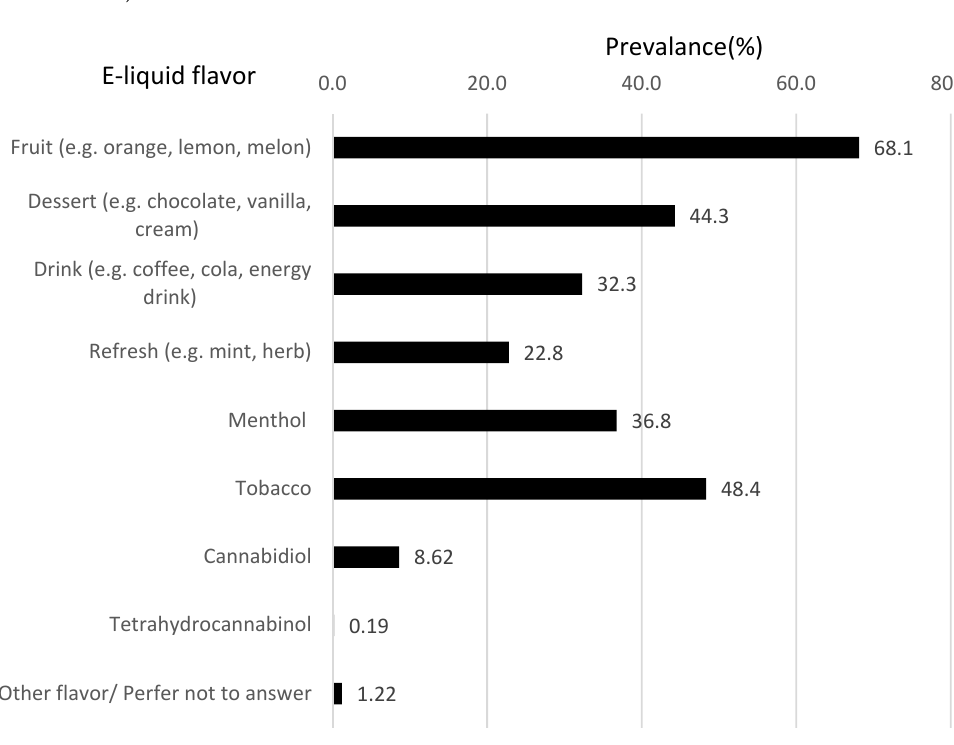
Figure 1. Favorite e-liquid flavors (multiple choice) among Japanese e-cigarette users.